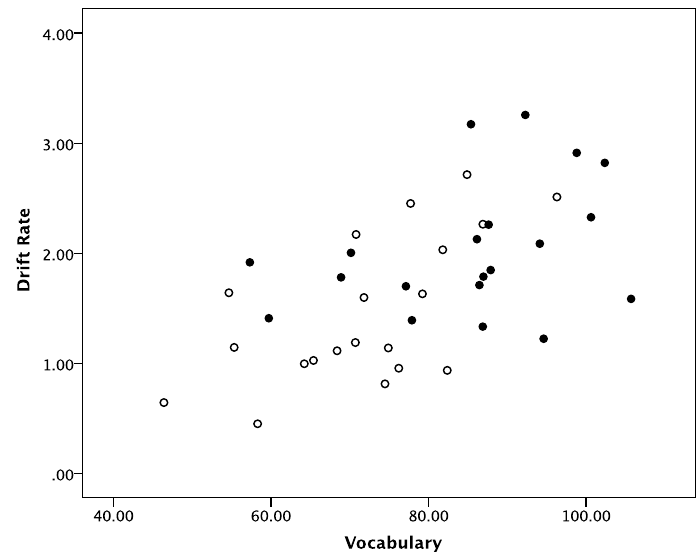
Figure 3. Relationship between drift rate and vocabulary by age group. Note: open circles = younger adults; filled circles = older adults.